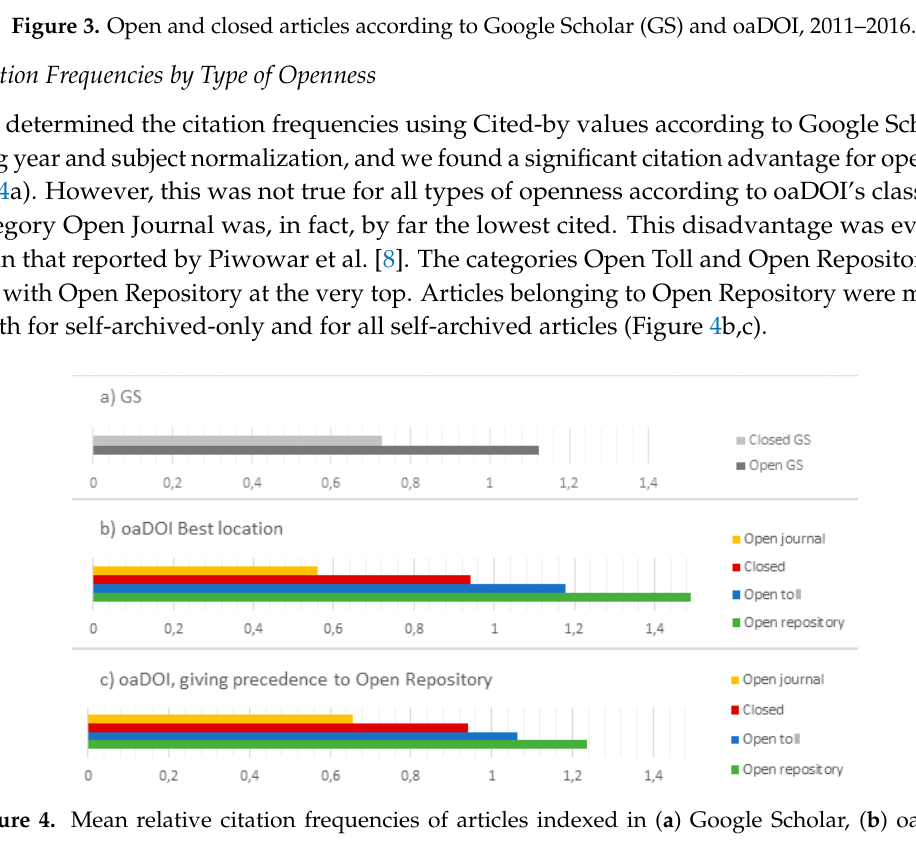
Figure 3. Open and closed articles according to Google Scholar (GS) and oaDOI, 2011–2016.